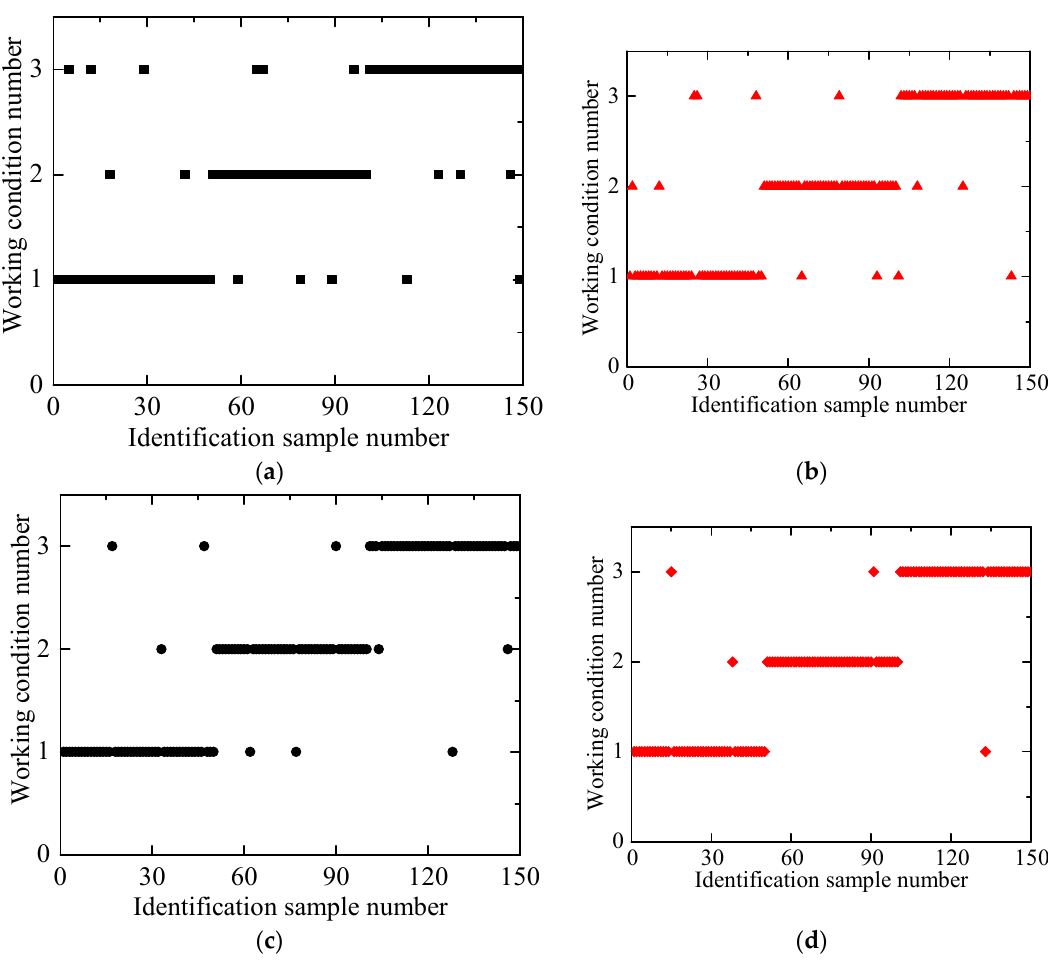
Figure 12. Recognition results of test samples for each classifier. ( a ) BP neural network; ( b ) Bayes identification method; ( c ) PNN; ( d ) AEPSO_PNN. Table 3. Singular value entropy results for the three working conditions. BP: back propagation. probabilistic neural network (PNN): probabilistic neural